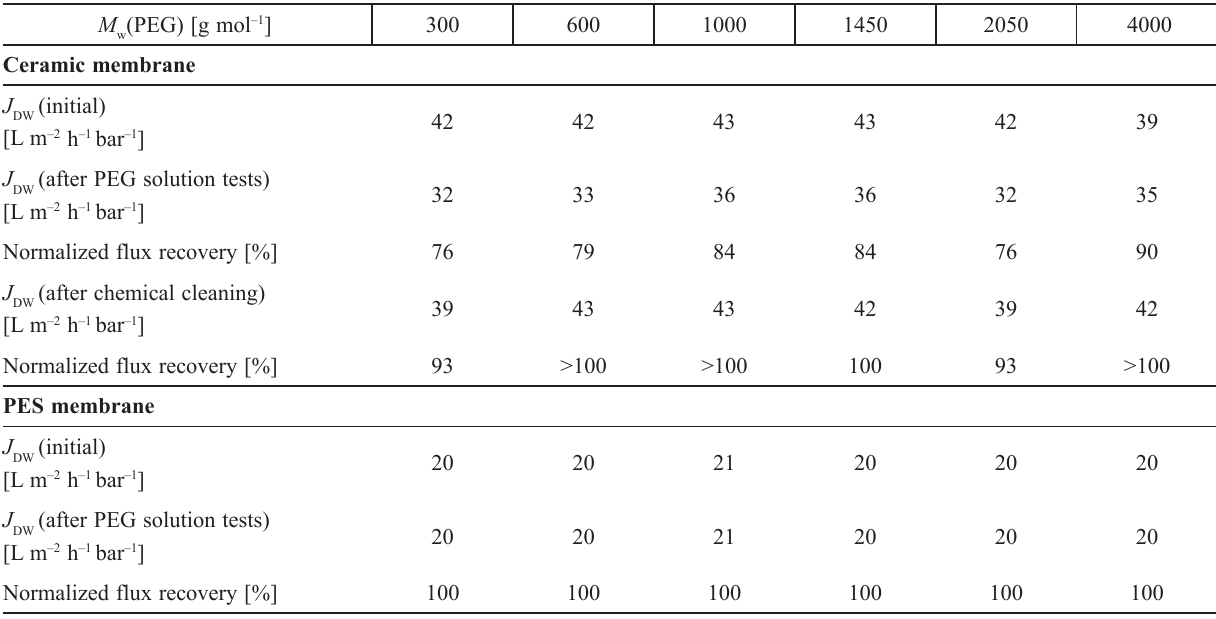
Table 1 – Evolution of the normalized permeate flux after forward flush and chemical cleaning using the ceramic and PES mem­ branes for tests with polyethylene glycol (PEG) solution 300 – 4000 g mol –1 (T = 20 °C) M (PEG) [g mol –1 w